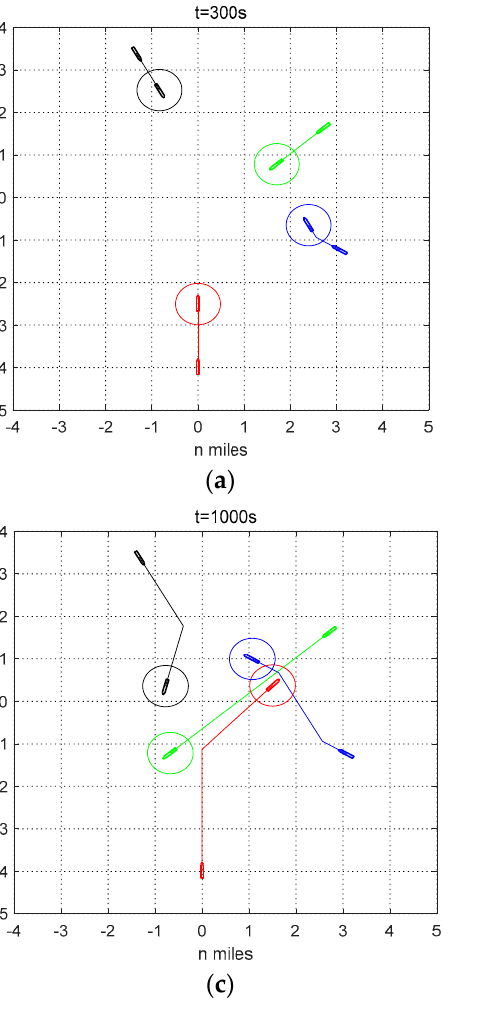
Figure 13. Ships’ trajectories under scenario 5: ( a ) the positions and paths of ships at 300 s, ( b ) the positions and paths of ships at 700 s, ( c ) the positions and paths of ships at 1000 s and ( d ) the positions and paths of ships at 1500 s. Table 6. Actions taken by each ship in scenario